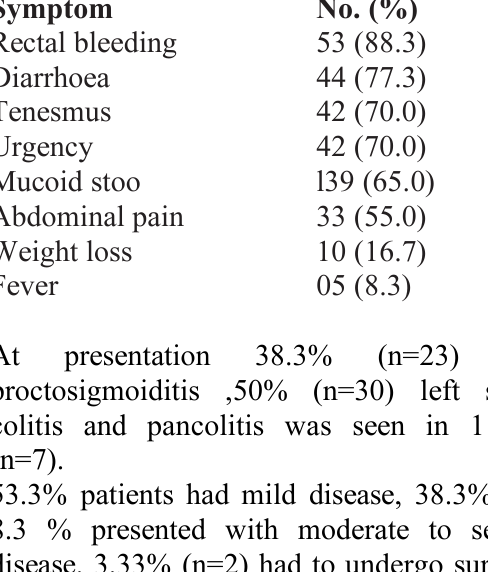
Table: 1 Symptoms at Diagnosis